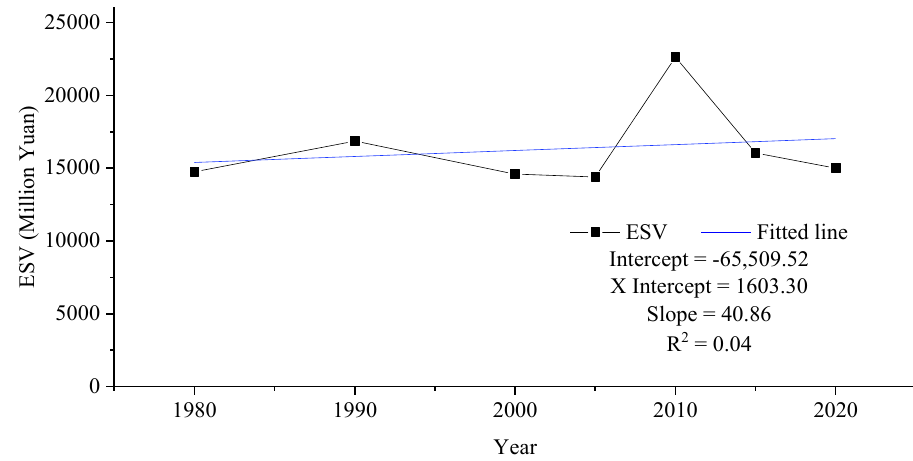
Figure 4. Values and trends of ESV in the lakeshore zone of Poyang Lake from 1980 to 2020.